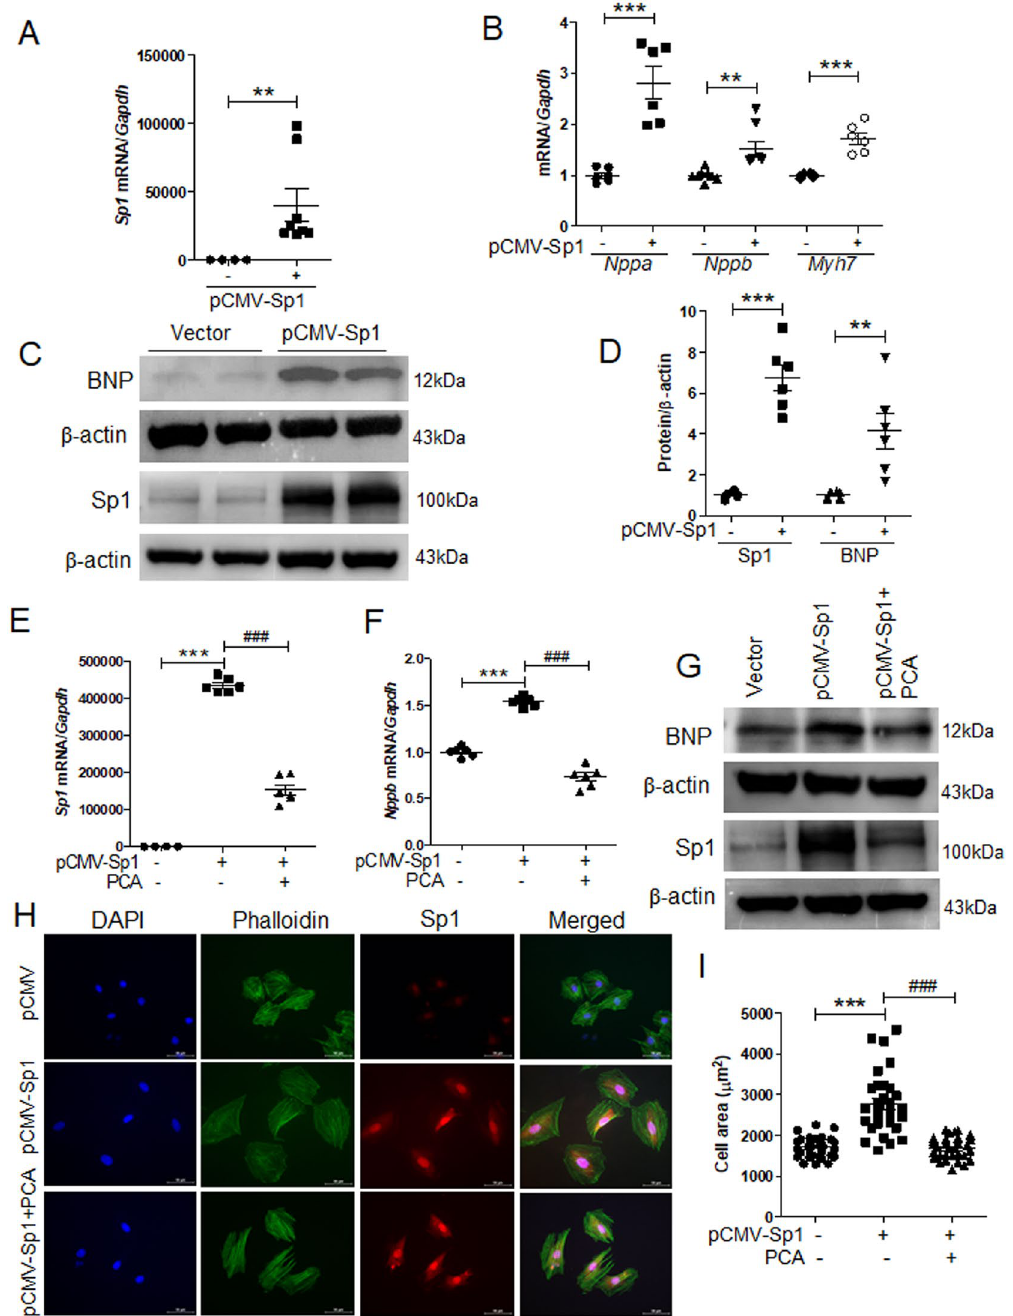
Figure 5. Protocatechuic acid ameliorates Sp1 overexpression-induced cardiac hypertrophy. H9c2 cells were transfected with empty vector or pCMV-Sp1 for 24 h. ( A ) Transcript levels of mouse Sp1 were quantified (n = 8). **P < 0.01, Student’s t -test. ( B ) The expression of hypertrophic marker genes ( Nppa (n = 6), Nppb (n = 8), and Myh7 (n = 6)) was determined by RT-PCR. **P < 0.01 and ***P < 0.001, Student’s t -test. ( C , D ) Representative western blot images and the quantification of Sp1 and BNP in pCMV-Sp1 and vector-transfected cells (n = 6). **P < 0.01 and ***P < 0.001, Student’s t -test. ( E , F ) Quantification of Sp1 and Nppb mRNA levels in cells transfected with vector or pCMV-Sp1 and treated with protocatechuic acid (10 μM, n = 6). ***P < 0.001; ### P < 0.001. ( G ) Sp1 and BNP protein expression in cells described in ( E , F) , representative Western blot images. ( H ) Representative images of the cells transfected with vector or pCMV-Sp1 , incubated with or without protocatechuic acid (10 μM), and then stained with anti-Sp1, Alexa Fluor 488 phalloidin, and DAPI. Sp1- positive cells (red); nuclei (blue); actin filaments (green). Scale bar = 50 μm. ( I ) Quantification of cell surface area (n = 30 cells). ***P < 0.001; ### P < 0.001 . Data are presented as the mean ± S.E. Statistical analysis: one-way ANOVA followed by Bonferroni post hoc tests. Graphs were prepared using GraphPad